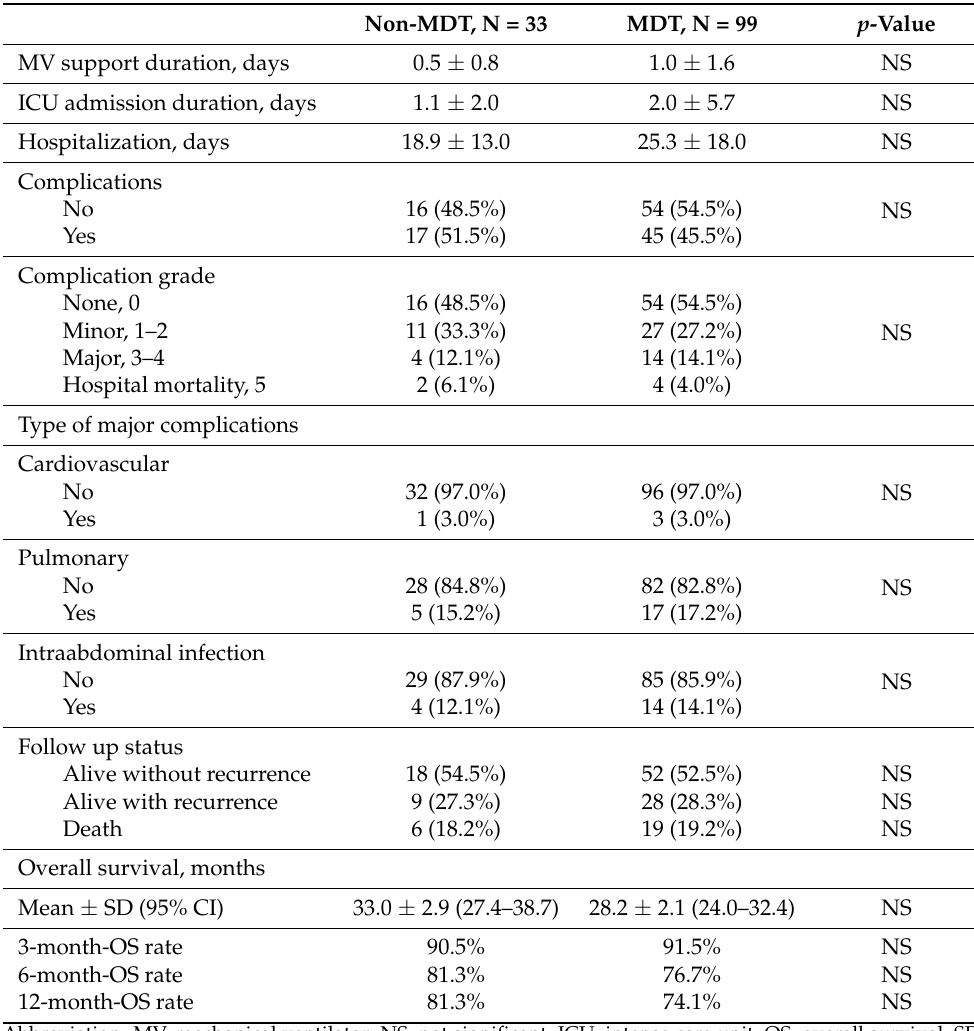
Table 3. Post-operative outcomes of the patients who underwent